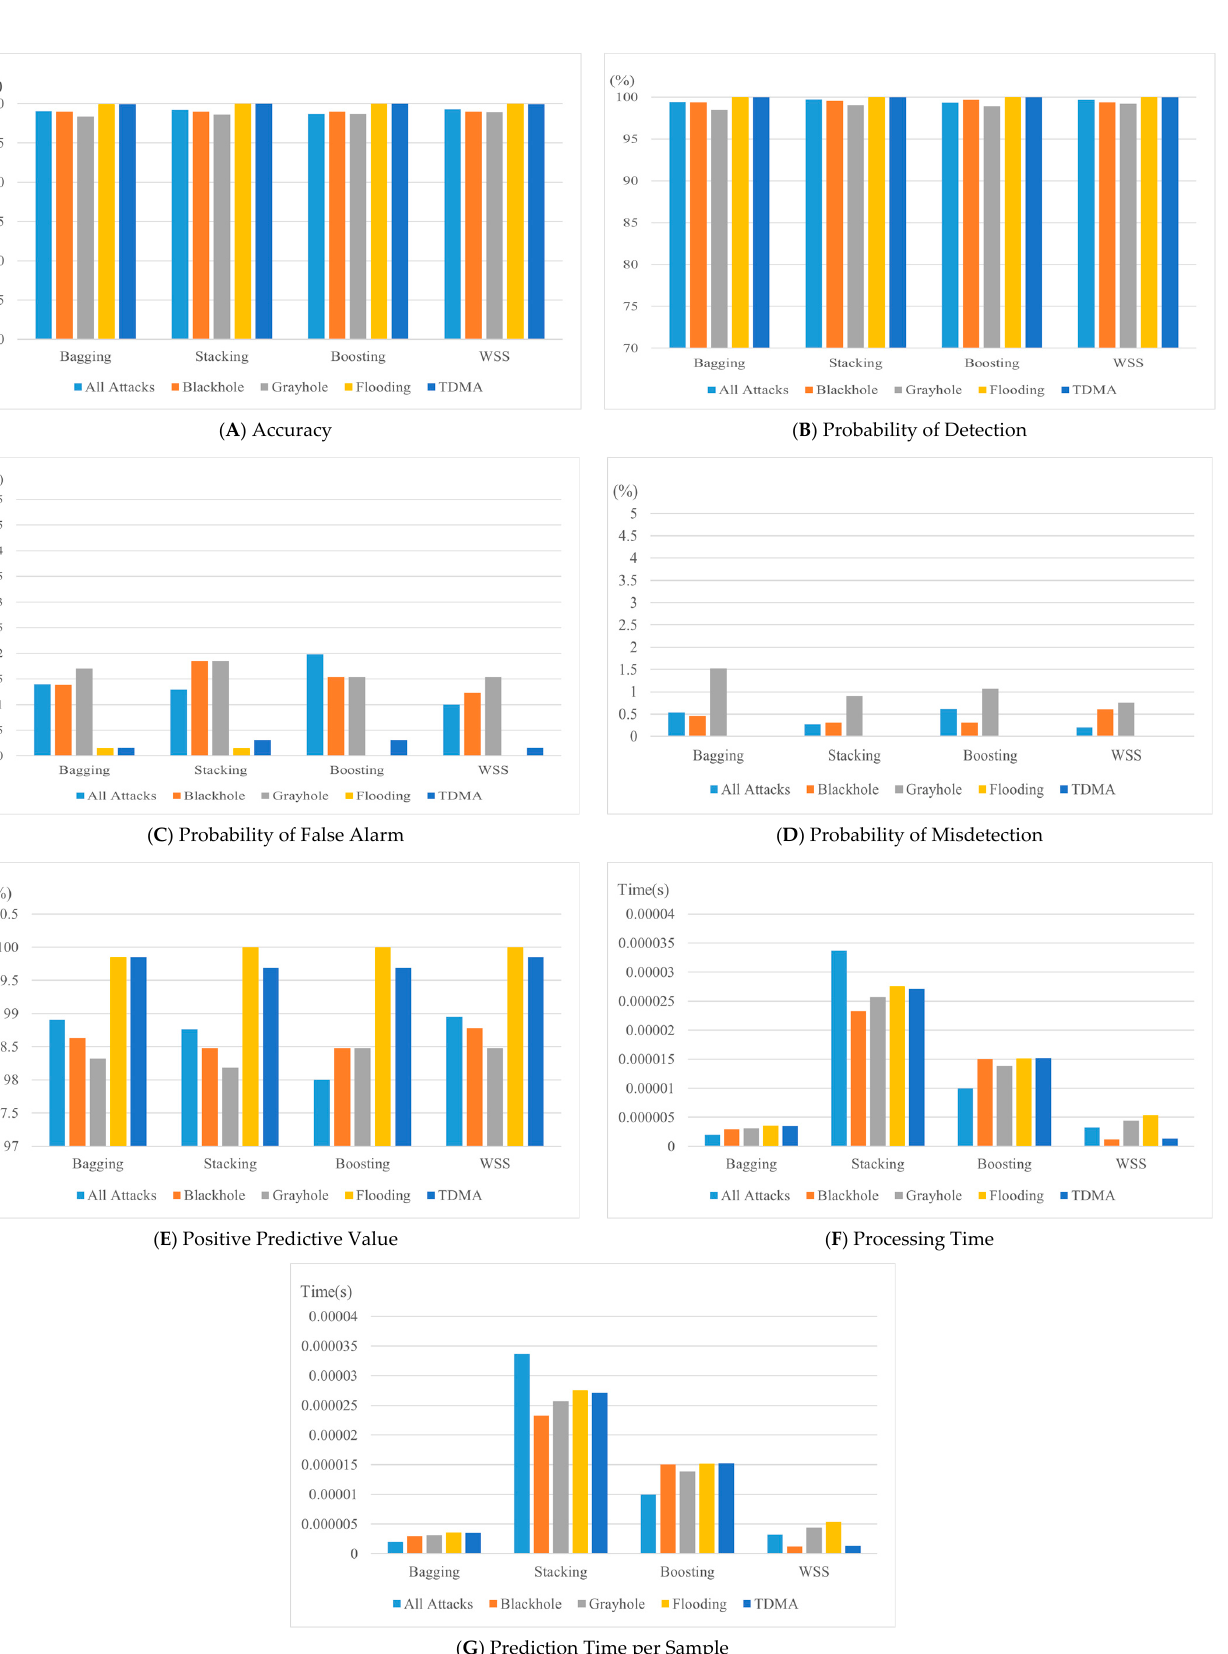
Figure 5. Results of WSS, Bagging, Boosting, and Stacking in terms of the evaluation metrics. WSS, Bagging, Stacking, and Boosting classifiers achieved approximately the same results regarding probability of detection (Figure 5B). Boosting was higher for the Black- hole dataset, at 99.69%, and Stacking was higher for the Grayhole dataset, at 99.08%. All models using the Flooding and TDMA datasets achieved the same results, 100%.